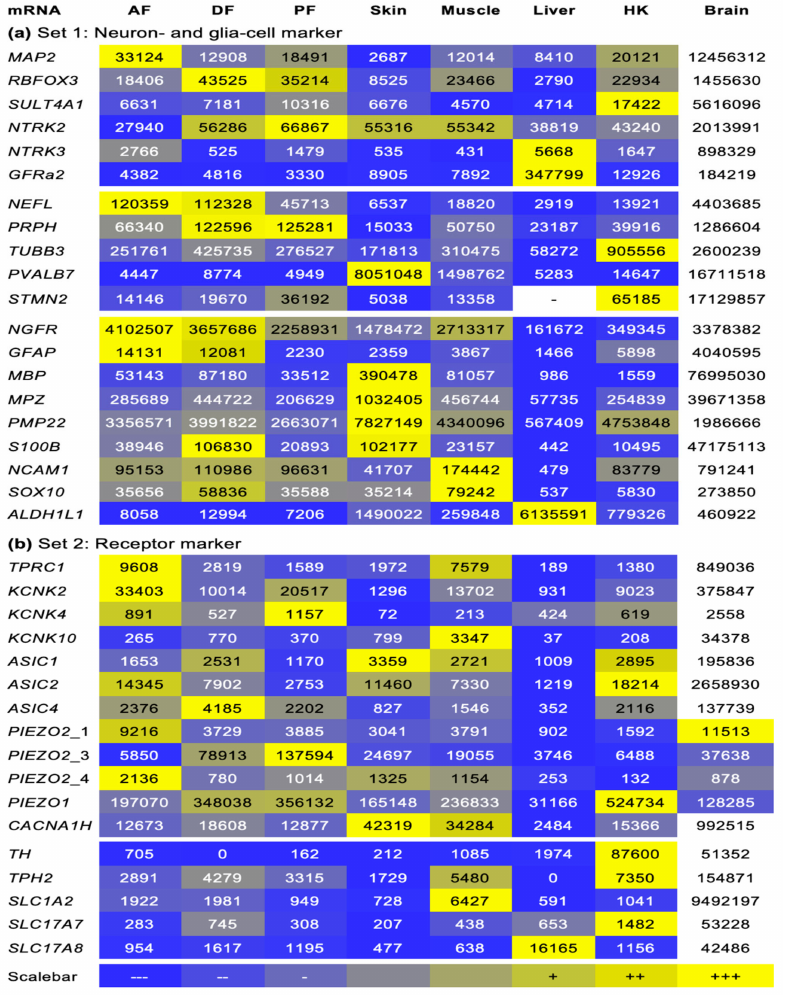
Figure 4. Expression profile of ( a ) neuron and glial cell- and ( b ) mechanoreceptor-specific marker genes across all the tissues investigated in O. mykiss . Field numbers indicate the absolute copy number per 1 µ g RNA. Color codes range from low abundance (dark blue) to high abundance (bright yellow) relative to the mean expression value of each particular gene. Expression in the brain was mostly excluded from the HeatMap illustration due to extremely high expression